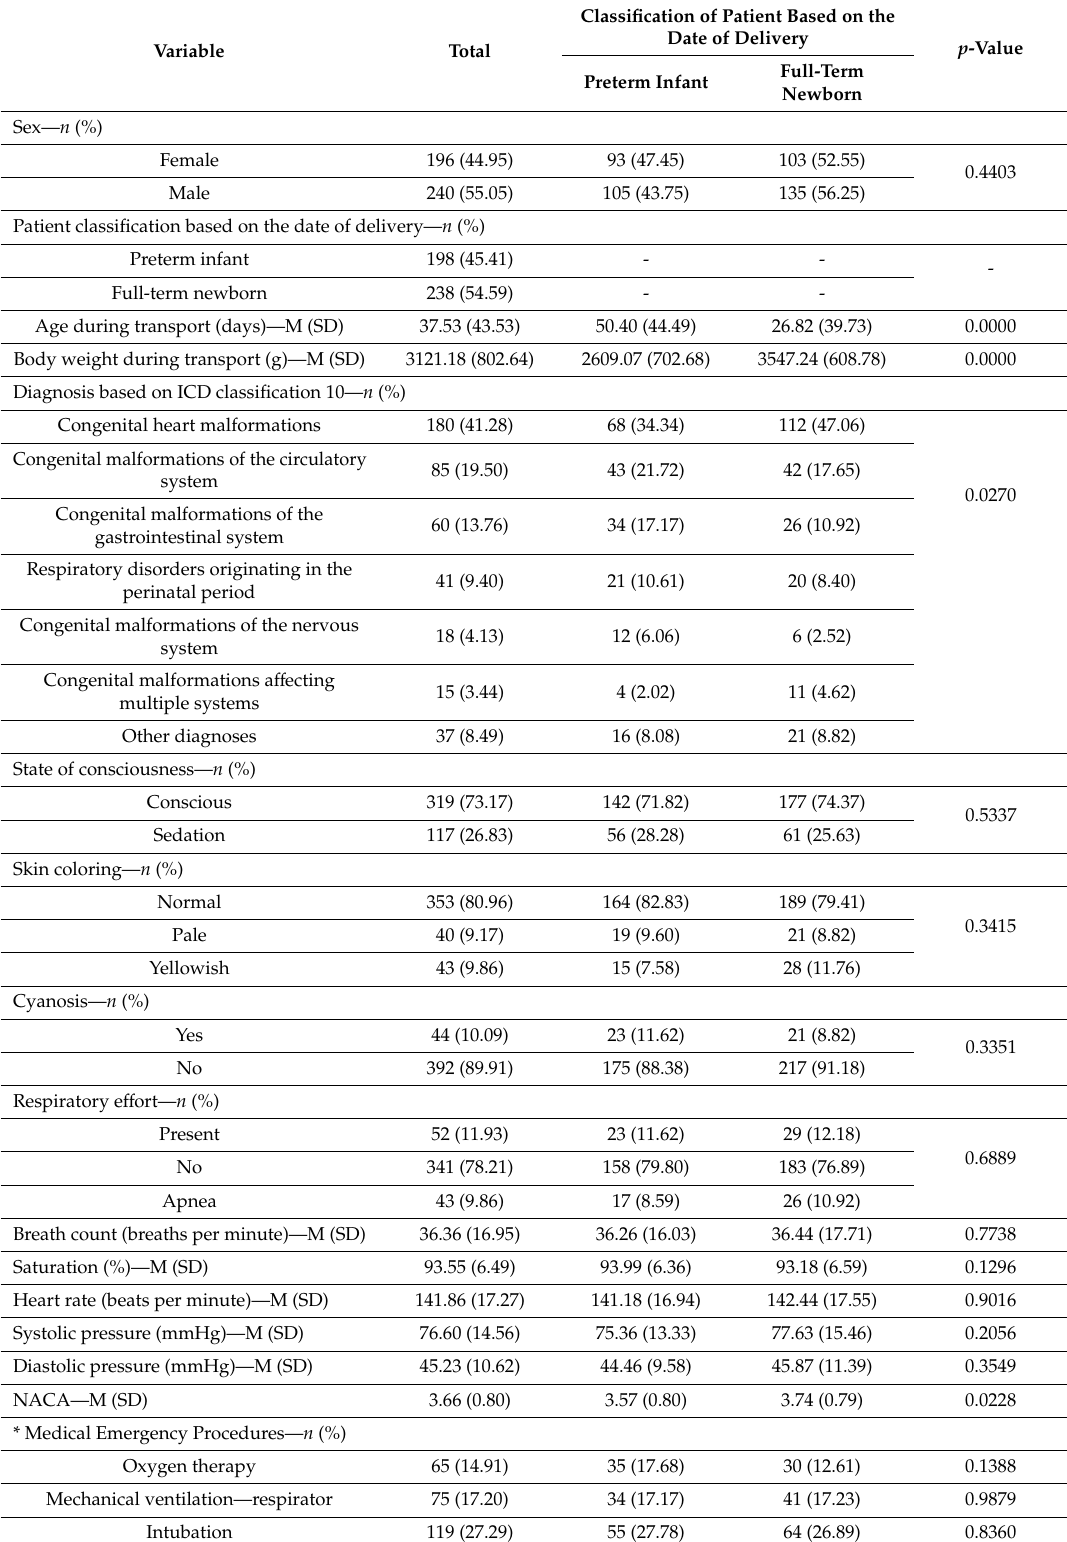
Table 1. Characteristics of patients transported in incubators and statistical analysis of classification of patients based on the date of delivery vs. patient sex, clinical condition and most frequent medical emergency procedures and medications. Classification of Patient Based on the Date of Delivery p -Value Variable Preterm